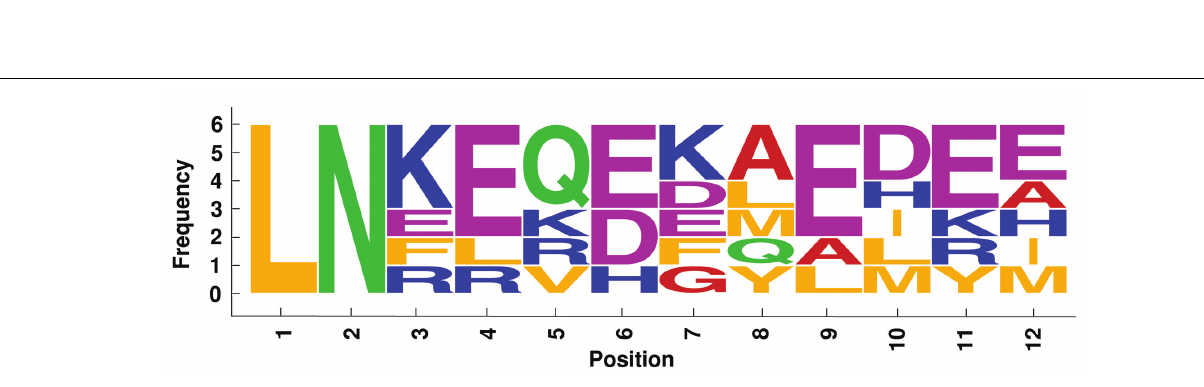
FIGURE 7 | Sequence logo of mapped residues in the best alignment of the 6 Ferritin